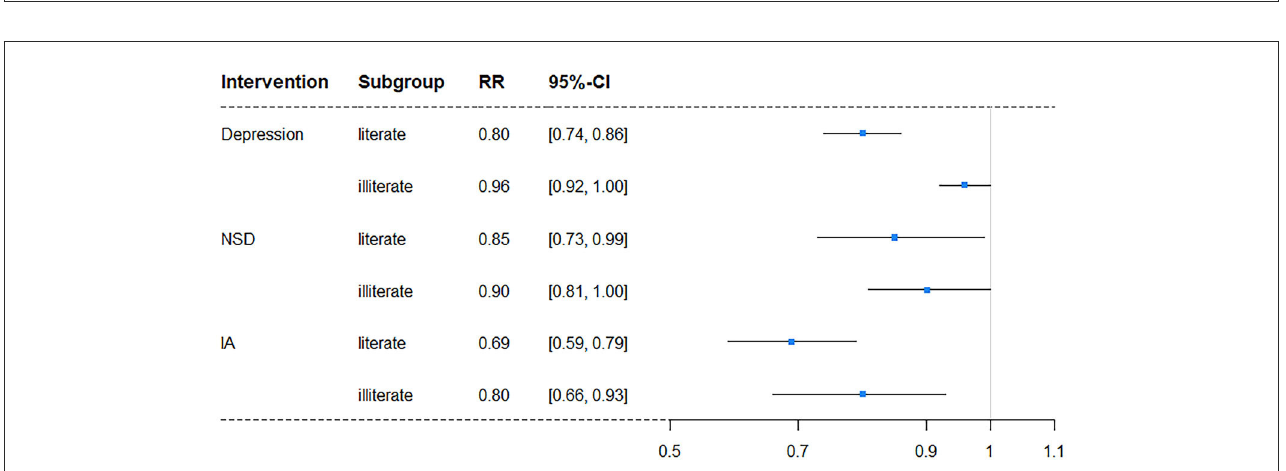
FIGURE3 Forest plot of RR for depression risk in subgroups stratified by education level (NSD, nighttime sleep duration; IA, intellectual activity, RR, risk ratio; CI, confidence